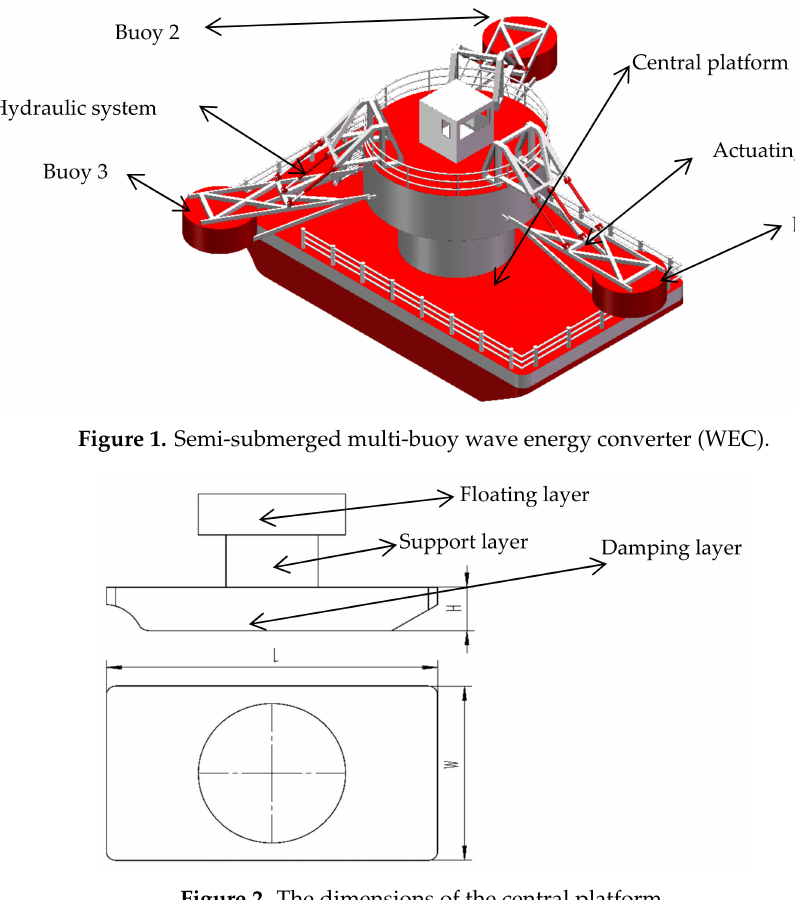
Figure 2. The dimensions of the central platform. Table 1. Initial parameters of the damping layer and